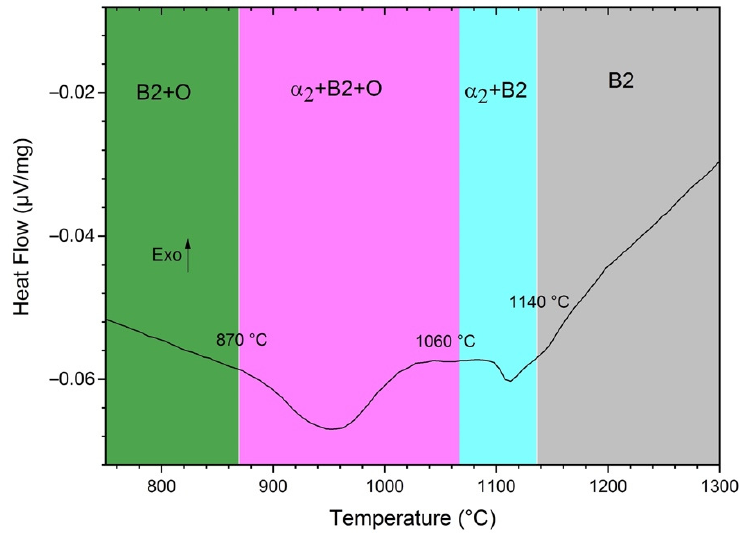
Figure 9. DSC curve of the sample fabricated from the Ti 2 AlNb-CYB powder.